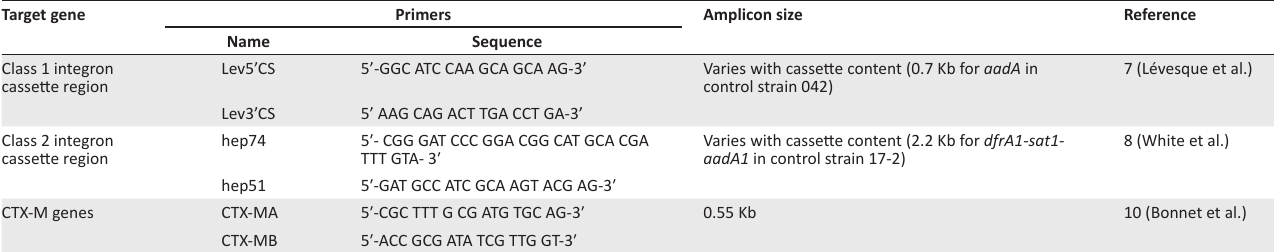
TABLE 2: Oligonucleotides for PCR reactions. Target gene